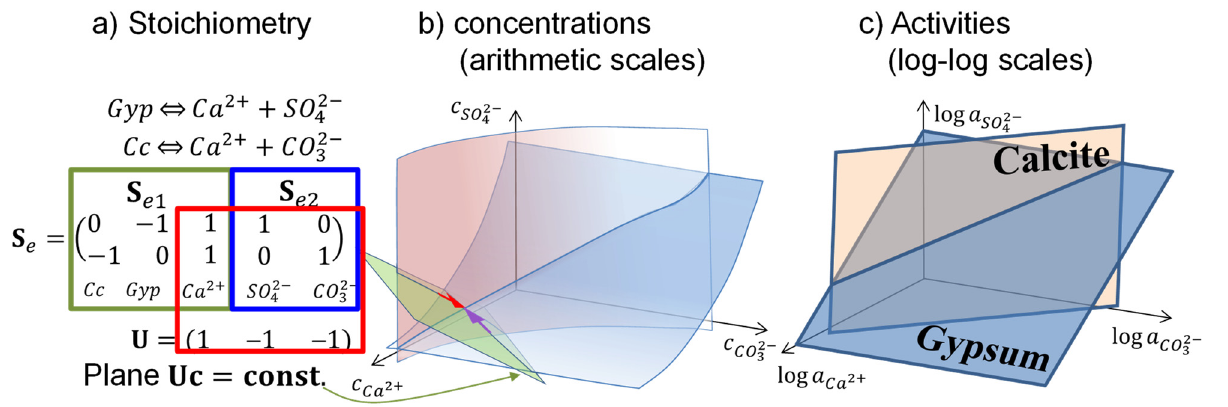
Figure 5. Simplified chemical system for calcite (Cc) and gypsum. The full stoichiometric matrix (blue and green squares) can be simplified (red) if mineral activities are constant (a). Equilibrium imposes constraints on concentrations, which must lie on equilibrium surfaces (b) that become planes in log activities (c). Reactions (red and purple arrows, b) lie on constant 𝐮 planes (green plane, b).